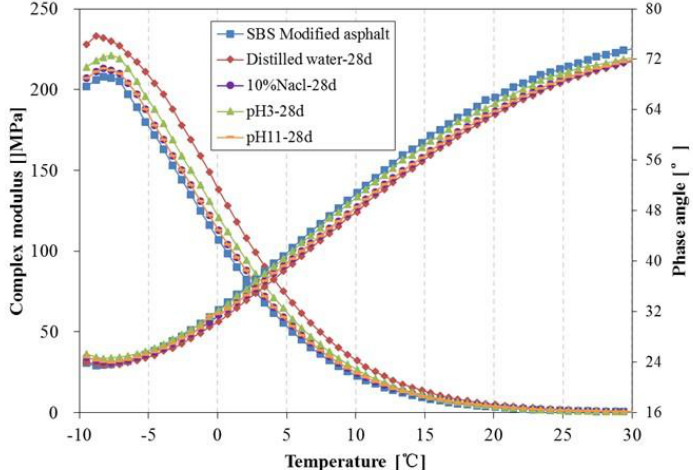
Figure 15. Complex modulus and phase angle of SBS modified asphalt before and after 28 days immersion.